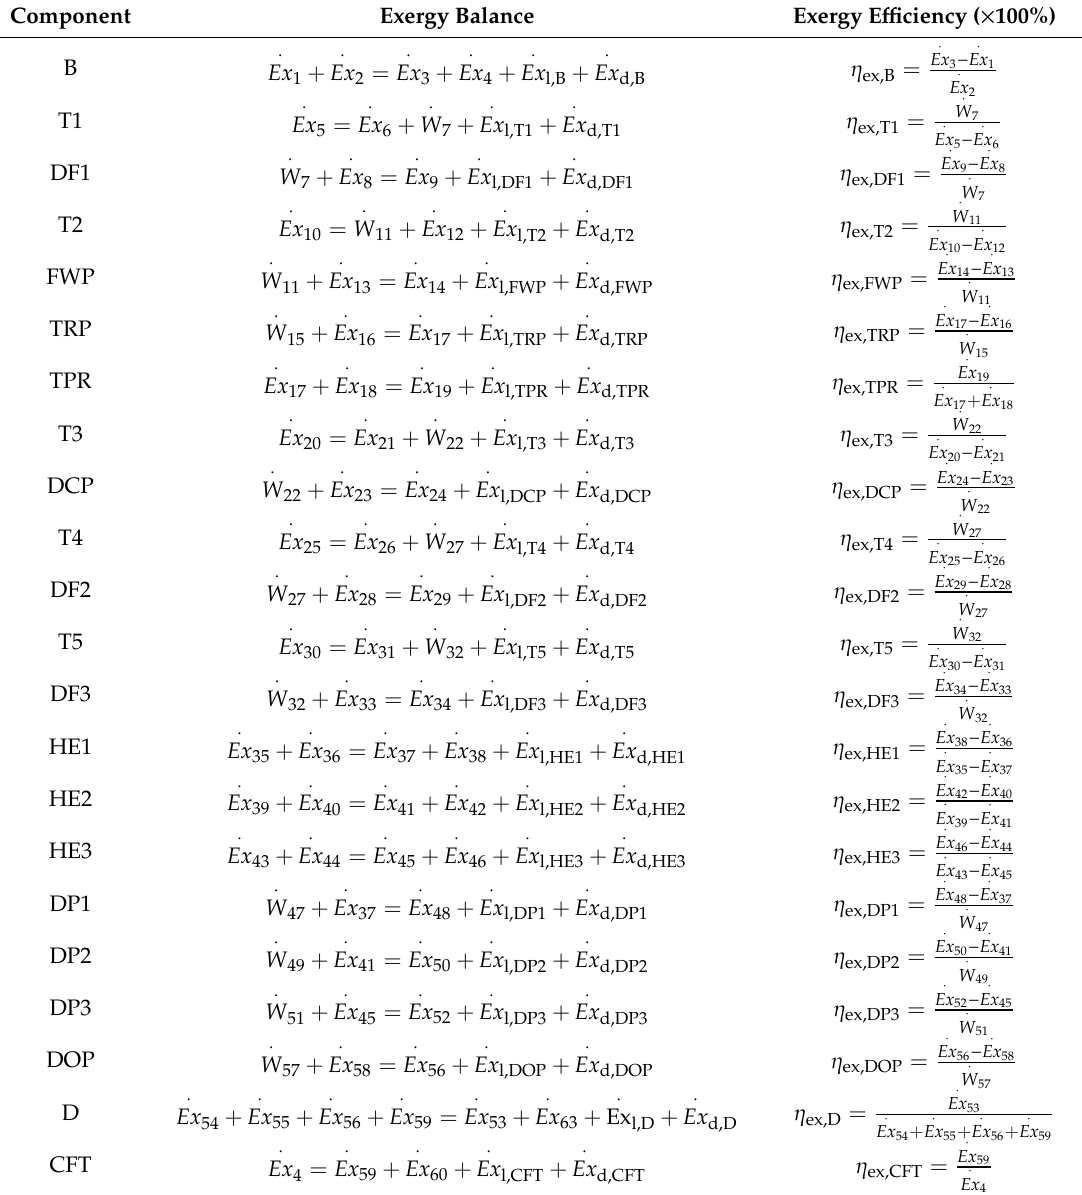
Table A2. Exergy balance and exergy e ffi ciency of every